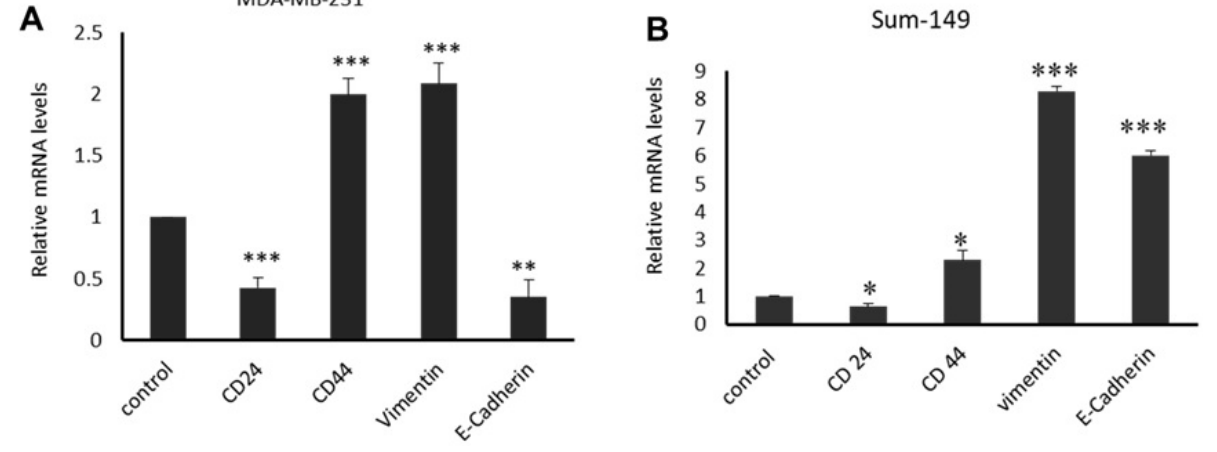
Figure 4. Quantitative real-time PCR. Expression levels of CD24, CD44, vimentin, and E-cadherin for breast cancer cell lines MDA-MB-231 and Sum-149 seeded in WF of non-IBC ( n = 12) and IBC ( n = 9) patients. ( A , B ) MDA-MB-231 and Sum-149 breast cancer cell lines were seeded for 48 h in culture media supplemented with 3% FBS (control), and 20% WF for treated cells. Bars represent relative quantification of mRNA expression of CD24, CD44, vimentin, and E-cadherin analyzed using 2 −ΔΔ Ct method after normalization to 18S (rRNA). Data represent mean ± SEM and were analyzed using the Student’s t -test. * p ≤ 0.05, ** p ≤ 0.01, and *** p ≤ 0.001. For IBC cell line Sum-149, the level of expression of CD44, vimentin, and E-cadherin were significantly upregulated—( p = 0.04), ( p = 0.000), and ( p = 0.000), respectively—and seeded in media conditioned by WF collected from IBC patients compared to the control.